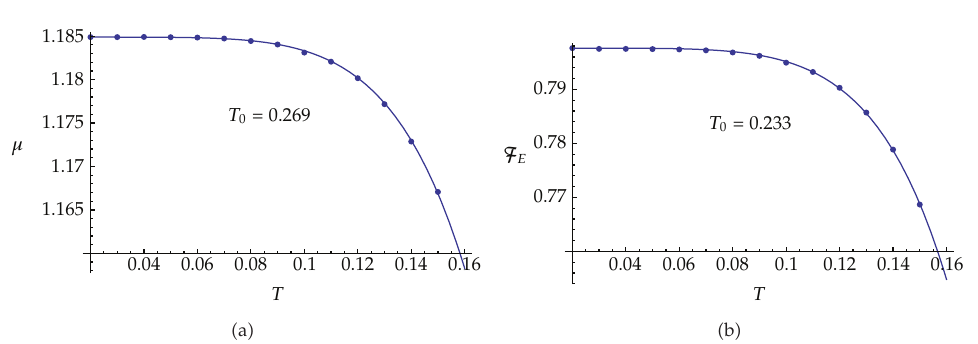
Figure 13: For d (cid:8) 1 , B (cid:8) 0 . 10, (cid:3) a (cid:4) the baryon chemical potential as a function of T , the best-fit curve (cid:14) is in the form μ 0 1 − (cid:3) T/T 0 (cid:4) 6 with μ 0 (cid:8) 1 . 1849 , T 0 (cid:8) 0 . 269; (cid:3) b (cid:4) the free energy as a function of T , the best-fit curve is in the form F 0